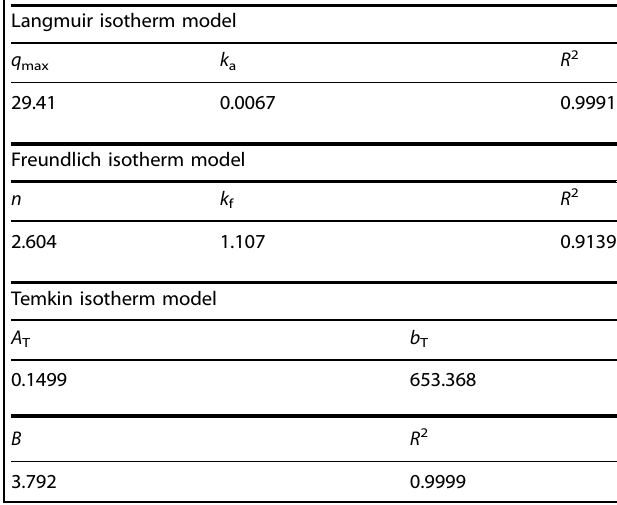
Table. 1. Parameters of Langmuir, Freundlich, and Temkin isotherms for the biosorption of Fe + 3 by A. niger